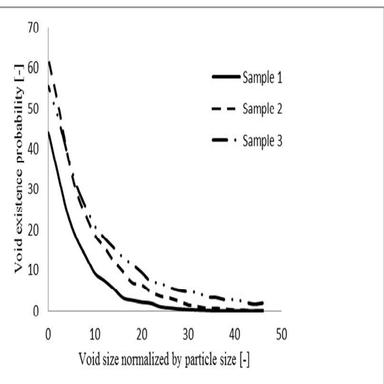
id size distribution of graphite electrodes of various packing density